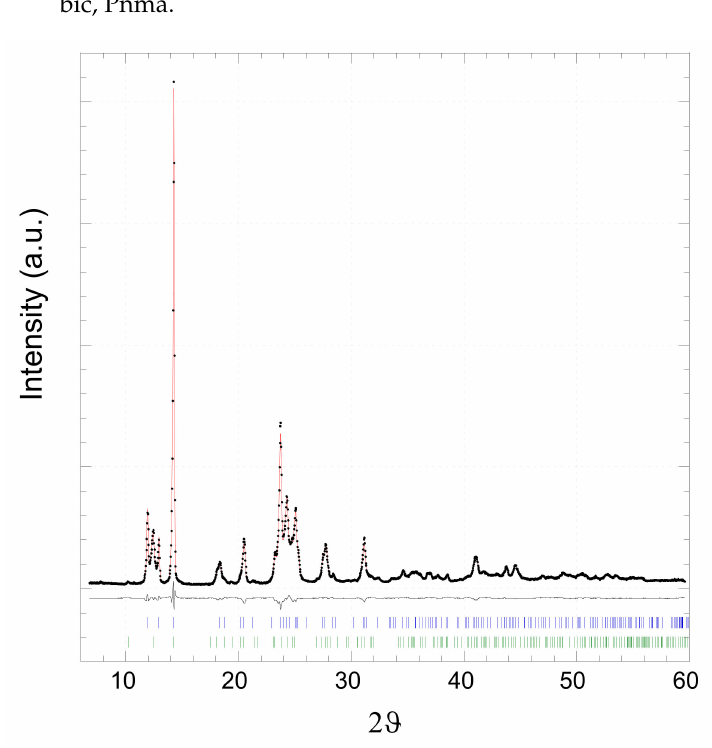
Figure 1. Rietveld refinement of XRPD pattern for the [Zn(4,4 (cid:48) -bipy)Cl 2 ] ∞ sample: experimental data (black dots), simulated curve (red line), and difference curve (black line). Lower vertical marks represent reflection positions of UBOCIX02 (blue) and UBOCIX03 (green) phase obtained by single-crystal data